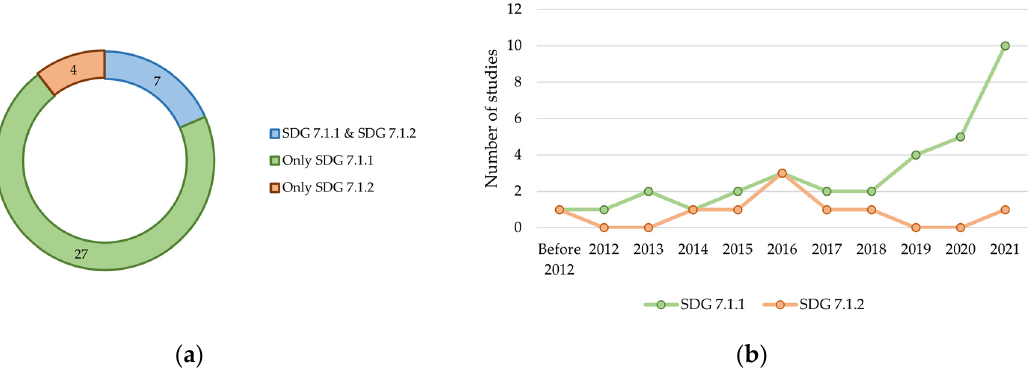
Figure A2. ( a ) Total number of studies on SDG 7.1.1 and SDG 7.1.2, and ( b ) Historic trend in publications on SDG 7.1.1 and SDG 7.1.2.